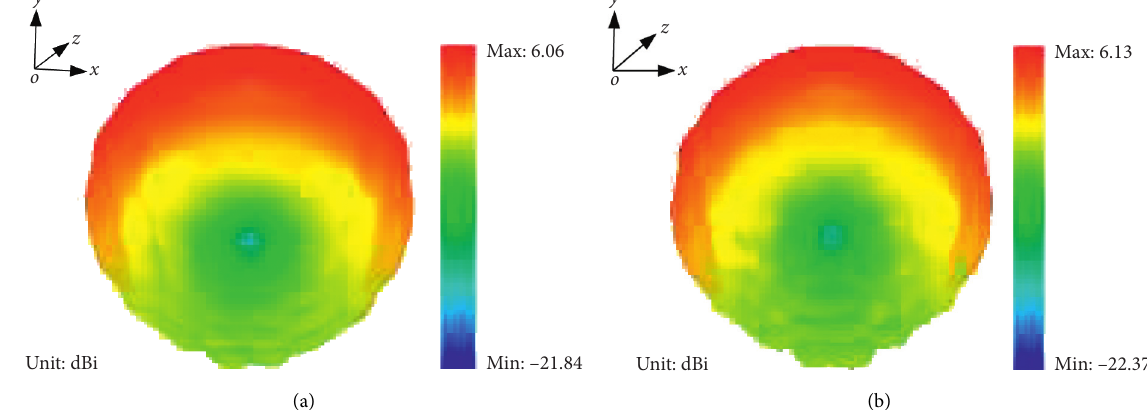
Figure 4: Comparison of the 3D radiation patterns. (a) Straight arms. (b) Bent arms.